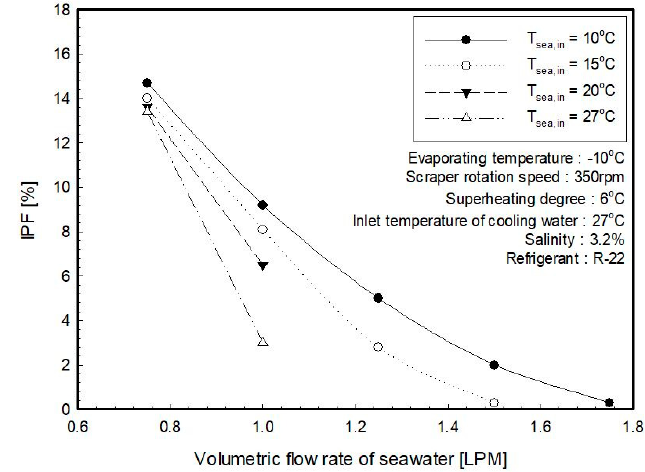
Figure 6. Influence of seawater flow rate on IPF for inlet temperature of seawater.